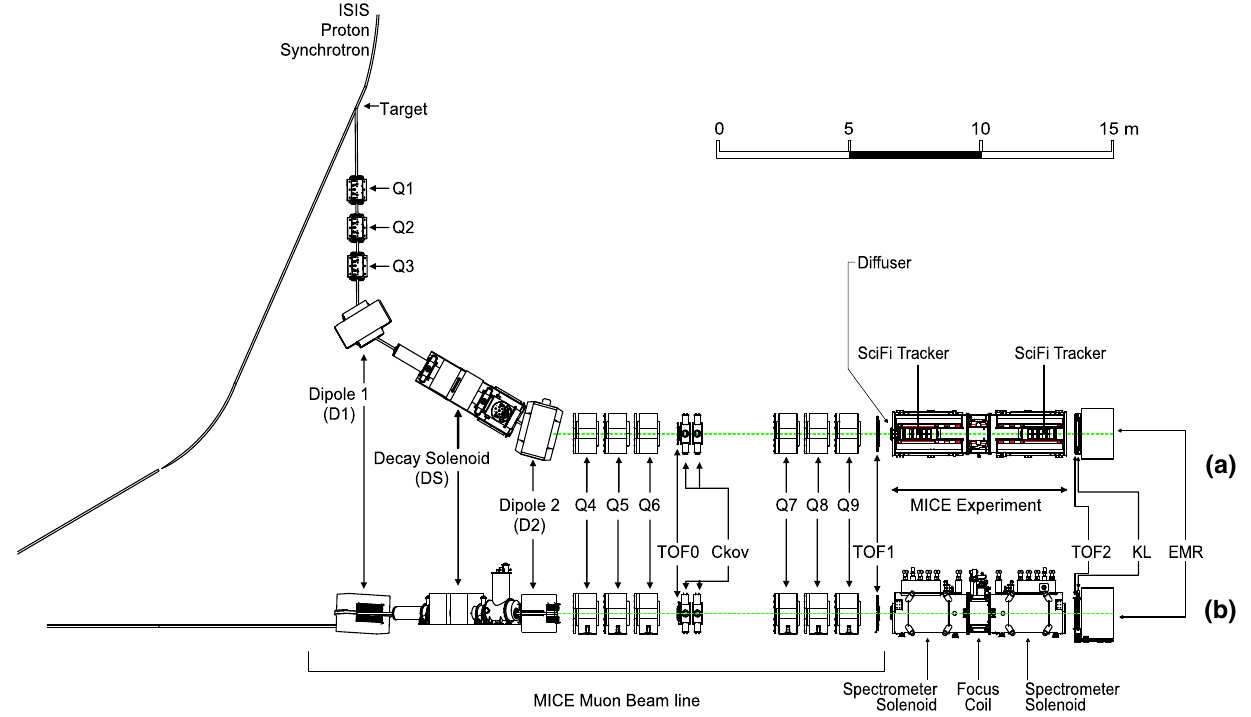
Fig. 2 a Top and b side views of the MICE Muon Beam line, its instrumentation, and the experimental configuration. A titanium tar- get dipped into the ISIS proton synchrotron and the resultant spill of particles was captured with a quadrupole triplet (Q1–3) and transported